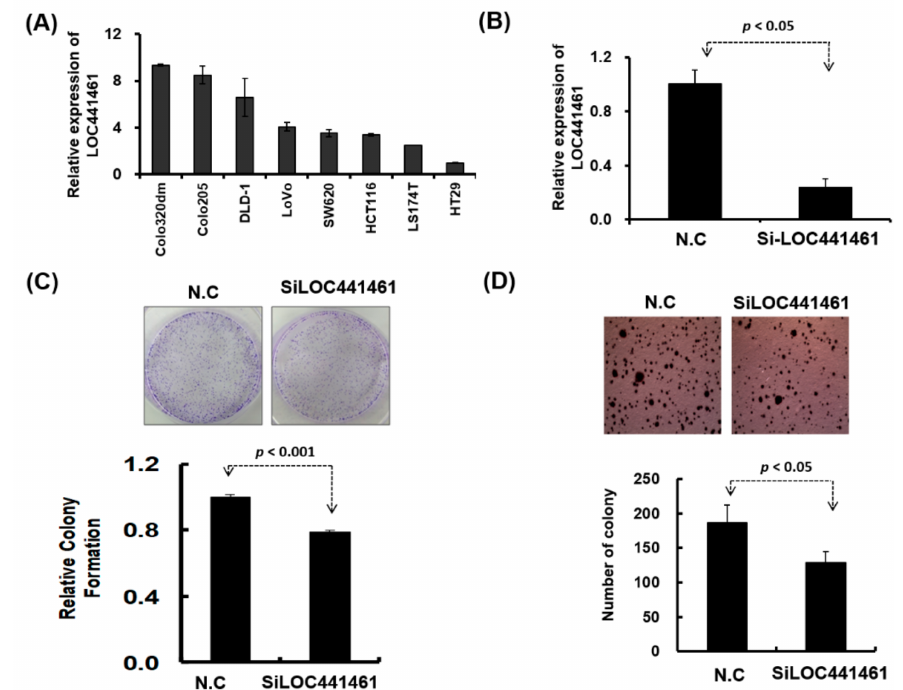
Figure 3. Biological function of LOC441461 was examined in colon cancer cells. ( A ) LOC441461 expression levels were examined in eight colon cancer cell lines by using RT-PCR. ( B ) LOC441461 expression levels were examined in SW620 cells with and without small interfering RNA (siRNA) transfection. ( C ) The colony formation assay was performed in the SW620 cells after transfection with si-Loc441461 and a scrambled control for 2 weeks. The cells were fixed and stained with crystal violet solution. The relative colony formation ability was then quantified (lower panel). ( D ) The anchorage-independent growth of SW620 cells with LOC441461 transfection was examined using the soft agar formation assay. A graph illustrates the quantified values. All experiments were performed in triplicate, and these data were analyzed using Student’s t test. The di ff erence was considered significant when p <